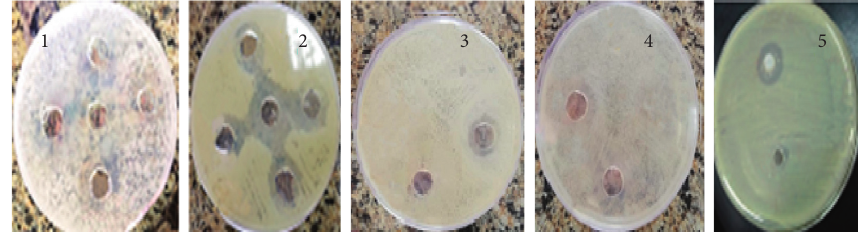
Figure 10: Antimicrobial activity (inhibition zones in mm) of Al +3 complex against the investigated microorganisms.1: Candida albicans , 2: Acinetobacter baumannii , 3: Staphylococcus aureus , 4: Enterococcus , and 5: Streptococcus mutans .